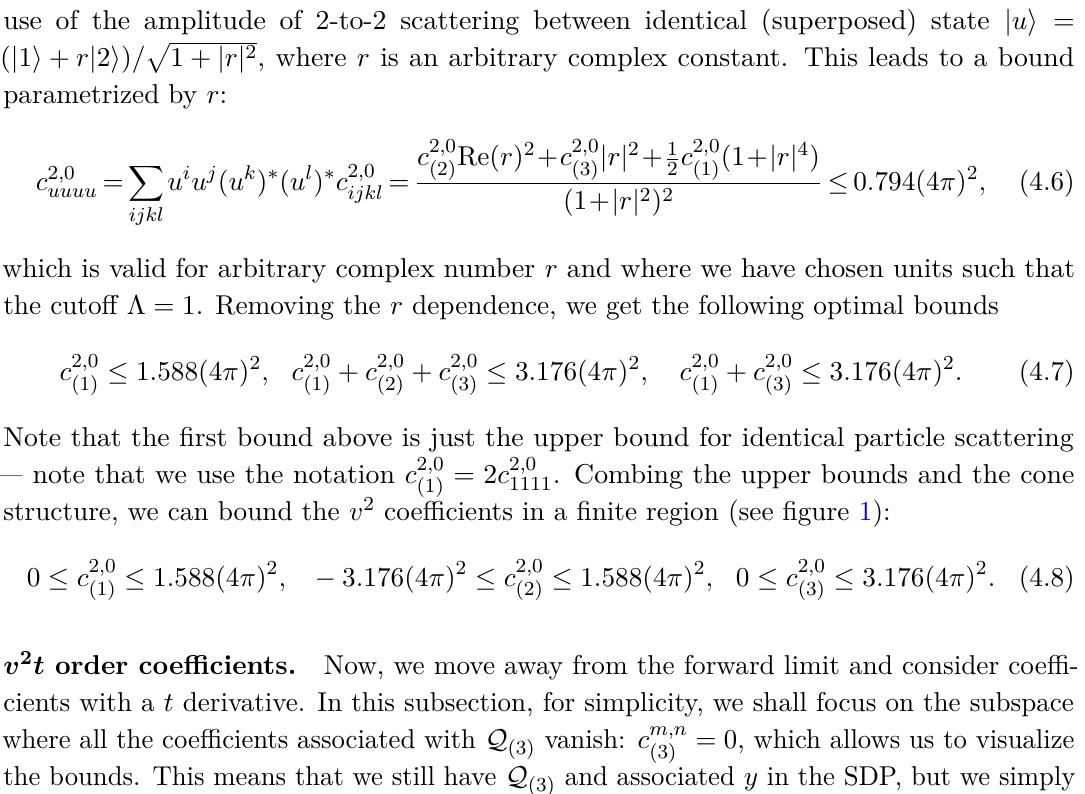
Figure 1 . Positivity bounds on ( c 2 , 0 for double Z bi-scalar theory. We have used both the convex cone lower bounds and the triple 2 crossing upper bounds with the first null constraint. The units are chosen such that Λ = 1